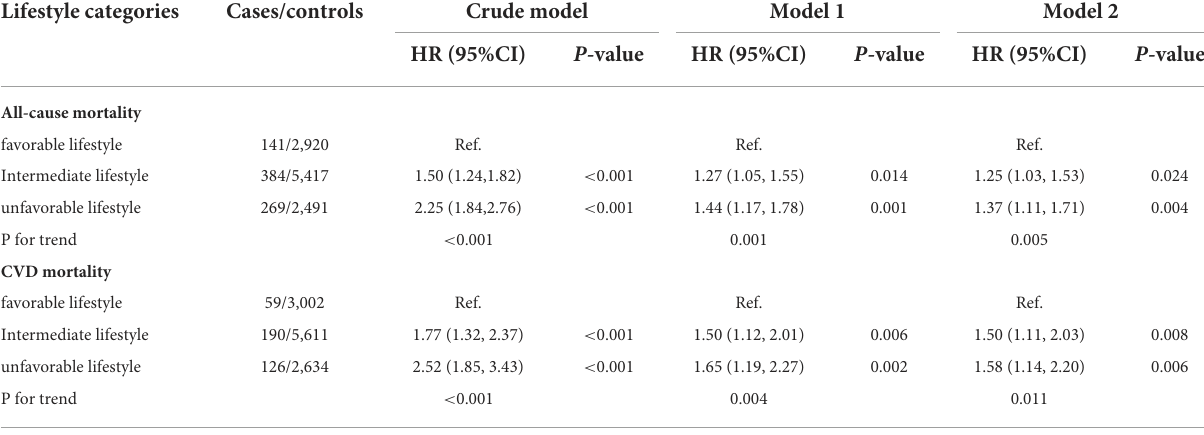
TABLE 2 Risk of incident all-cause and cardiovascular disease mortality according to lifestyle categories. Lifestyle